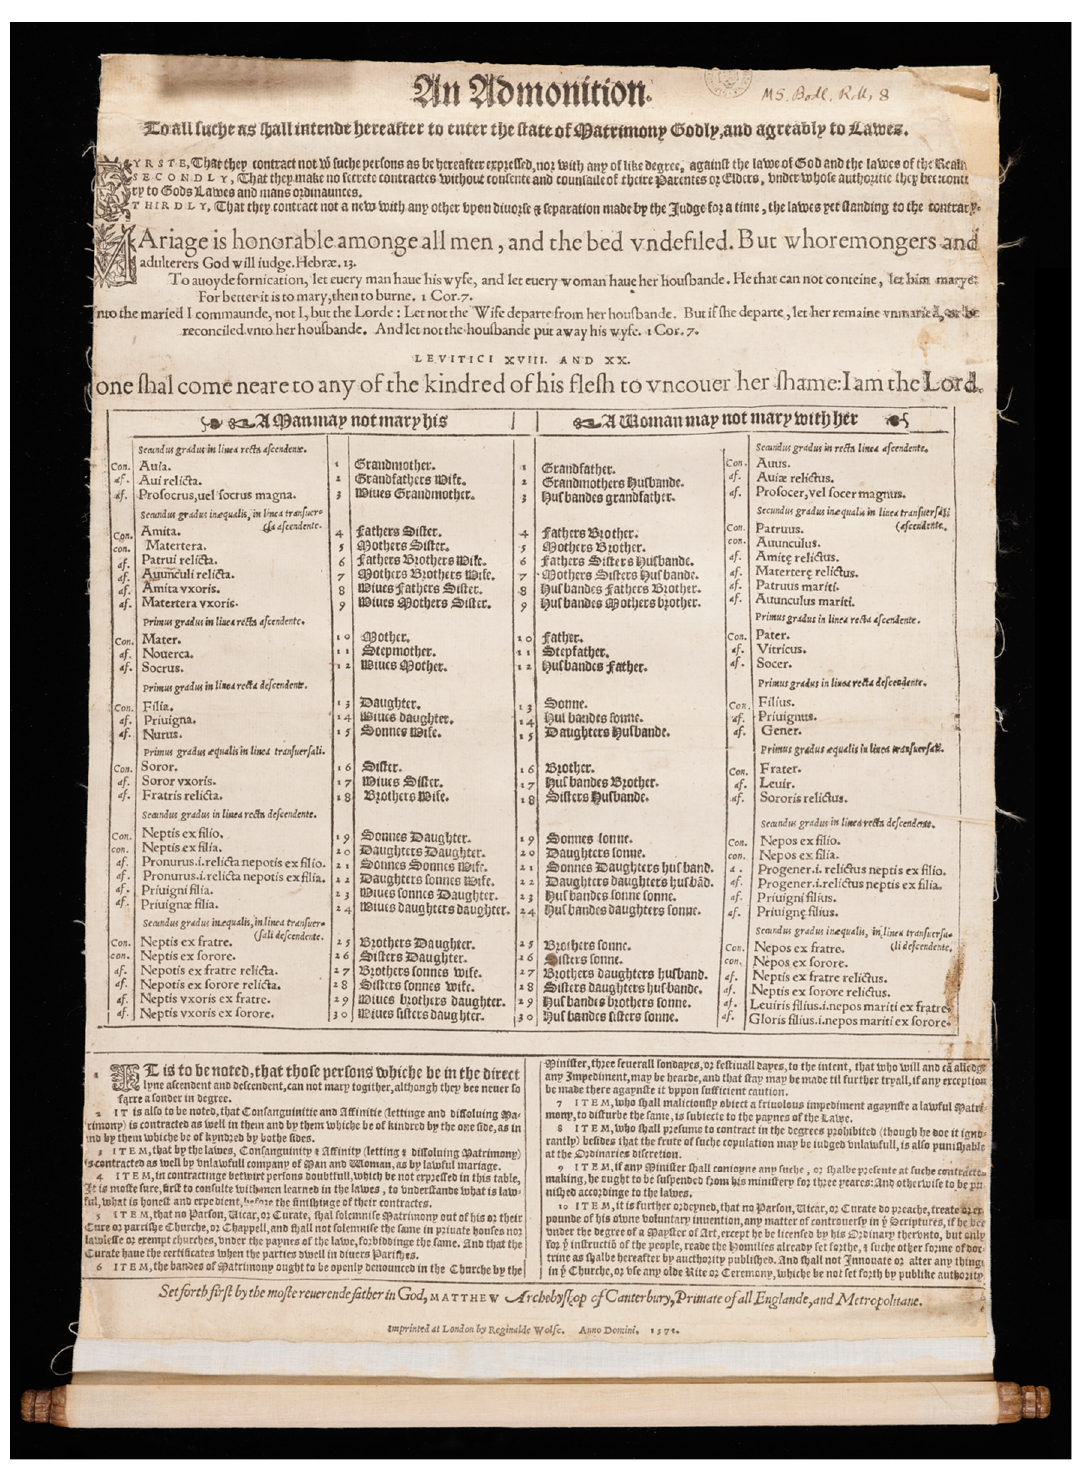
Figure 18. Matthew Parker, Archbishop of Canterbury, An Admonition. To all suche as shall intende hereafter to enter the state of Matrimony Godly, and agreably to Lawes. London: Reginald Wolfe, 1571. First published in 1563. The Bodleian Libraries, University of Oxford, MS. Bodl. Roll. 8, final section.